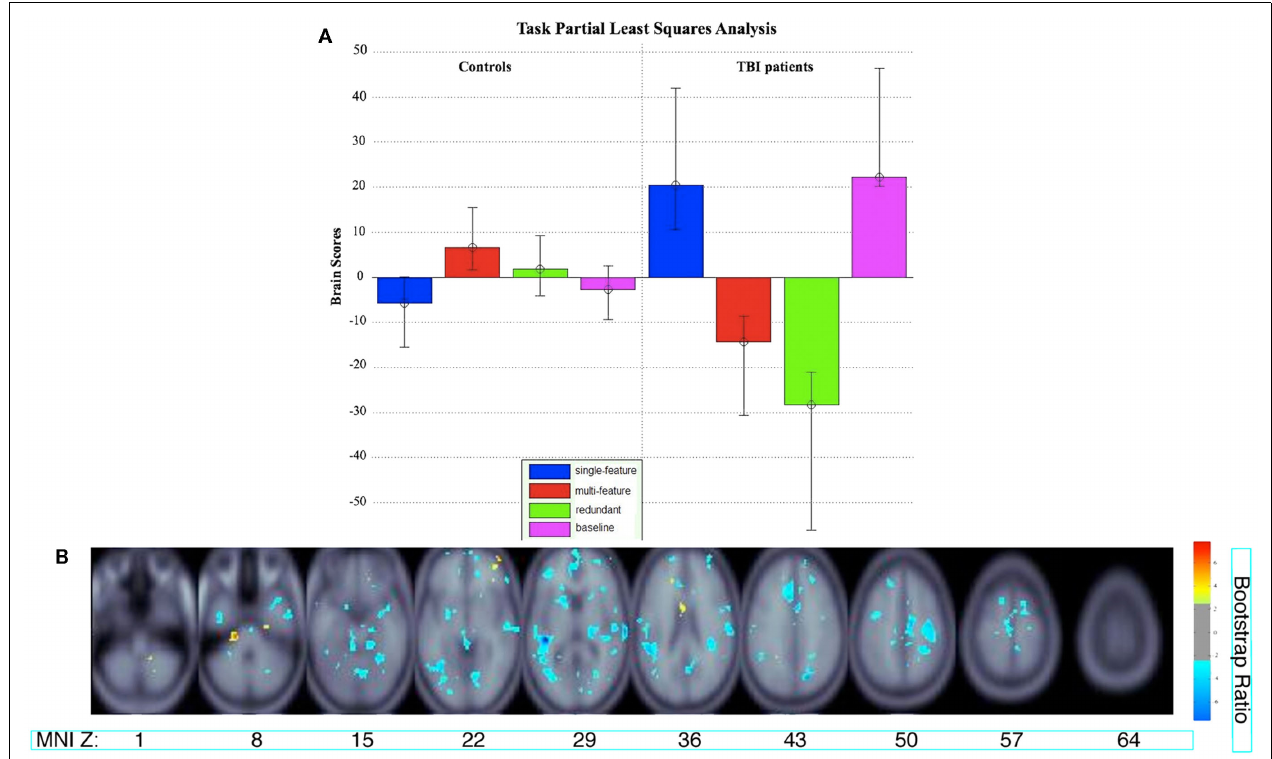
number of voxels ≥ 250 for negative saliences, bootstrap ratio ≥± 2.5).The brain activity patterns occur five lags (10s) after stimulus onset time.The X axis shows the location of the axial slice with a coordinate along the Z axis in MNI atlas space.Warm colors indicate clusters with positive bootstrap ratios, which were more active in group and task conditions with positive brain scores in (A) . Cool colors indicate clusters with negative bootstrap ratios, which were more active for group and task conditions with negative brain scores. Letter designations serve as a cross-reference to regions listed in Table 2 .The bootstrap ratio map is superimposed on the average anatomical scans from all 18